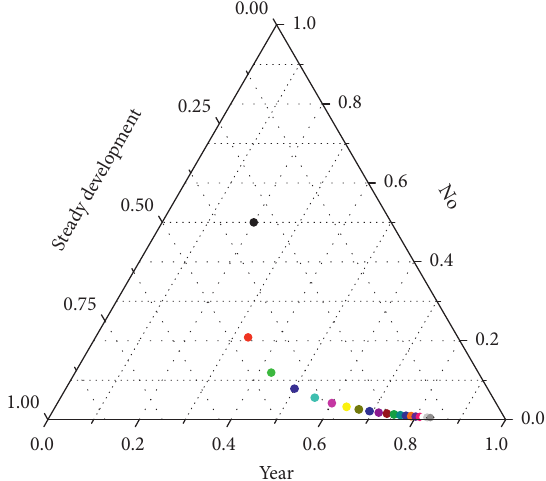
Figure 10: The results of environmental and social issues affecting the coordination of transportation